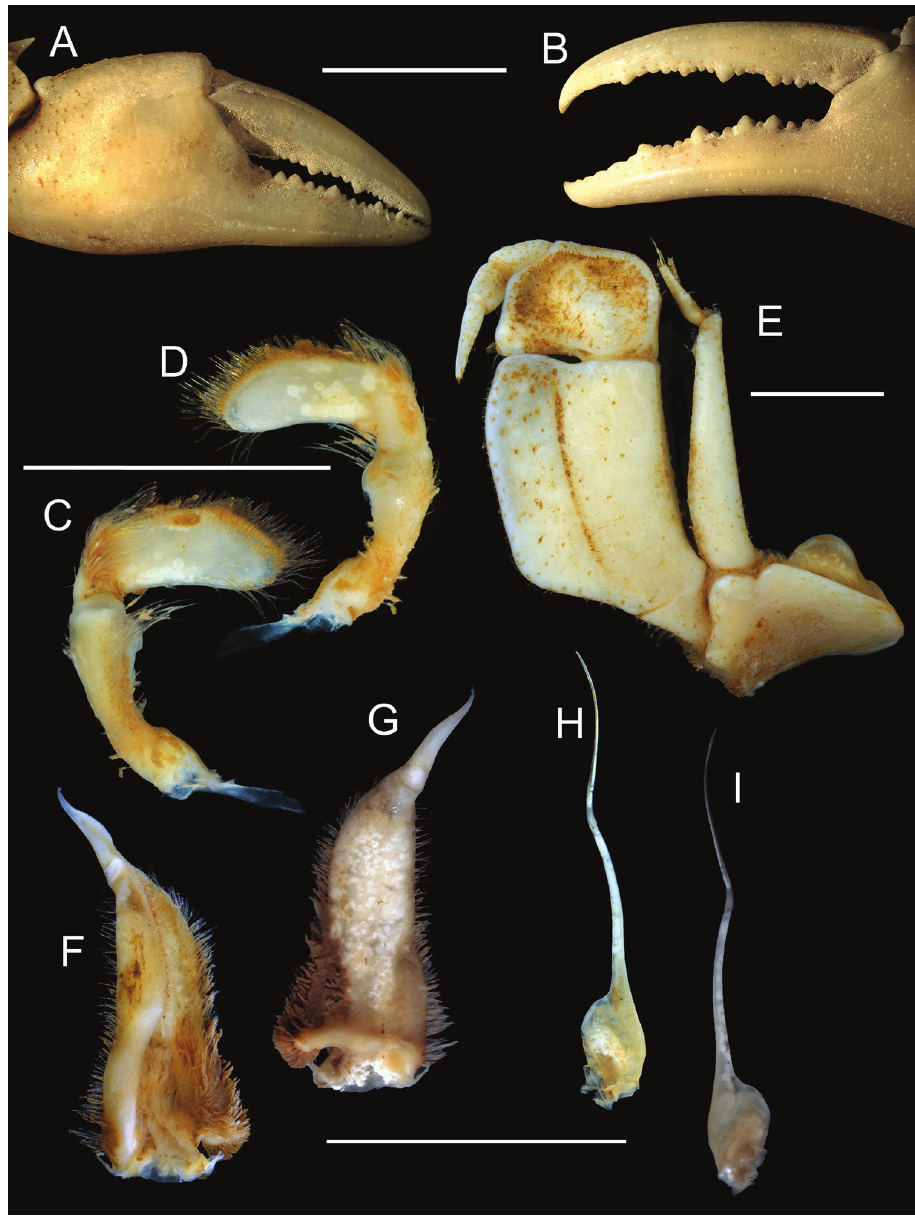
Figure 5. Potamonautes sidneyi (Rathbun, 1904). male holotype CWW 47 mm (Yale Peabody Museum catalogue number 1191) A major cheliped B minor cheliped C right mandibular palp posterior view D right mandibular palp anterior view E 3 rd maxilliped F left gonopod 1 anterior view G left gonopod 1 posterior view H left gonopod 2 anterior view, and I left gonopod 2 posterior view. Scale bars: 5 mm ( A, B ), 5 mm ( C, D ), 5 mm ( E ), 10 mm ( F, G, H, I ). Photos: Eric